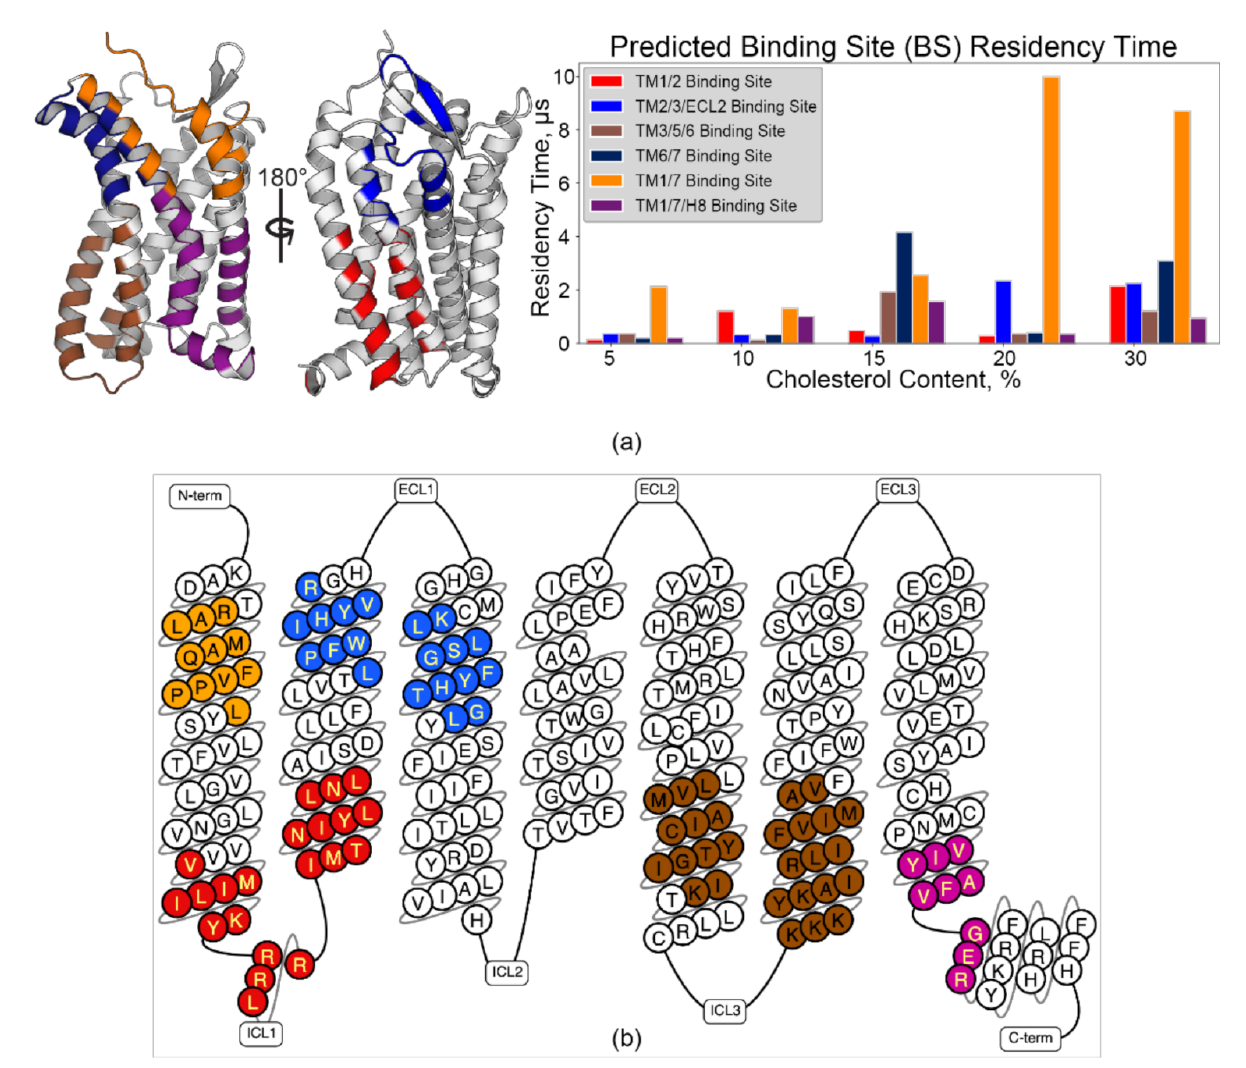
Figure 4. Pylipid-predicted cholesterol binding sites are conserved across membrane conditions and populated with CRAC/CARC motifs. ( a ) Binding sites are mapped onto the model (left), with cholesterol residency time plotted as a function of membrane cholesterol % (right) for binding sites identified in grooves between TM helices. ( b ) CRAC/CARC motifs are color-coded by which predicted binding site they are found within, produced using the GPCRdb